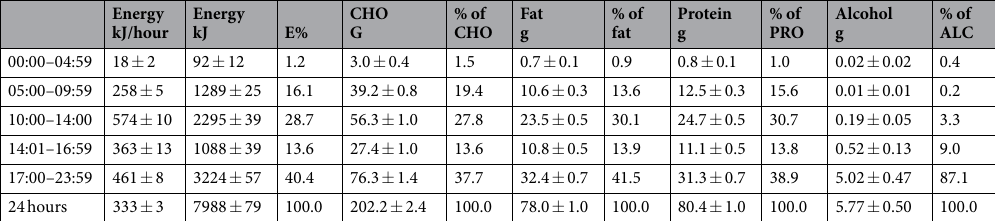
Table 2. Energy and macronutrient intakes at different times of the day. Data are presented as mean ± SE or percentage of total energy. E%, percentage of total energy; CHO, carbohydrates; PRO, proteins; ALC,